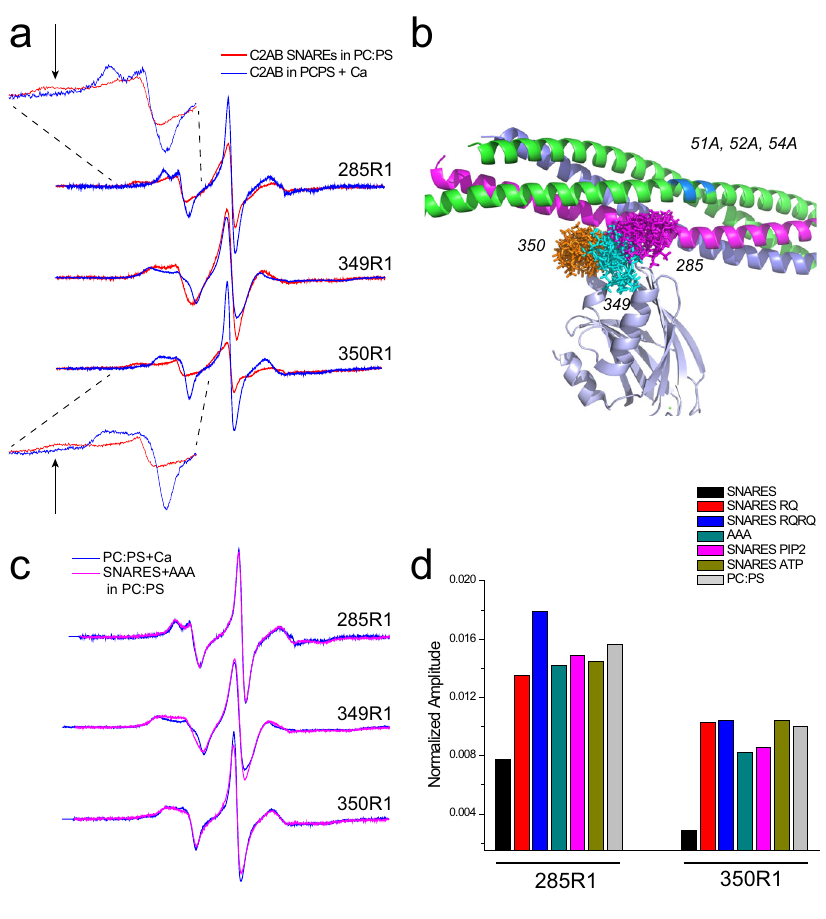
Fig. 4 The arginine apex contacts membrane reconstituted SNAREs, but ATP or PIP 2 in the bilayer, eliminate the interaction. a EPR spectra in the absence (blue trace) or presence (red trace) of membrane reconstituted SNARE complex composed of full-length Syx, SNAP-25, and soluble Syb. The broadened components in the spectra (arrows) are due to incompletely averaged axial components of the hyper fi ne tensor and indicate tertiary contact of the R1 side chain with SNAREs. b Model (PDB ID 5CCH) with available rotamers for the R1 side chains at the three sites. c Comparison of EPR spectra with and without membrane reconstituted SNAREs containing the AAA mutation in SNAP-25. d Normalized amplitudes for EPR spectra from sites 285R1 and 350R1. The normalized amplitudes provide a semi-quantitative measure of R1 motion where larger amplitudes indicate loss of R1 tertiary contact with the